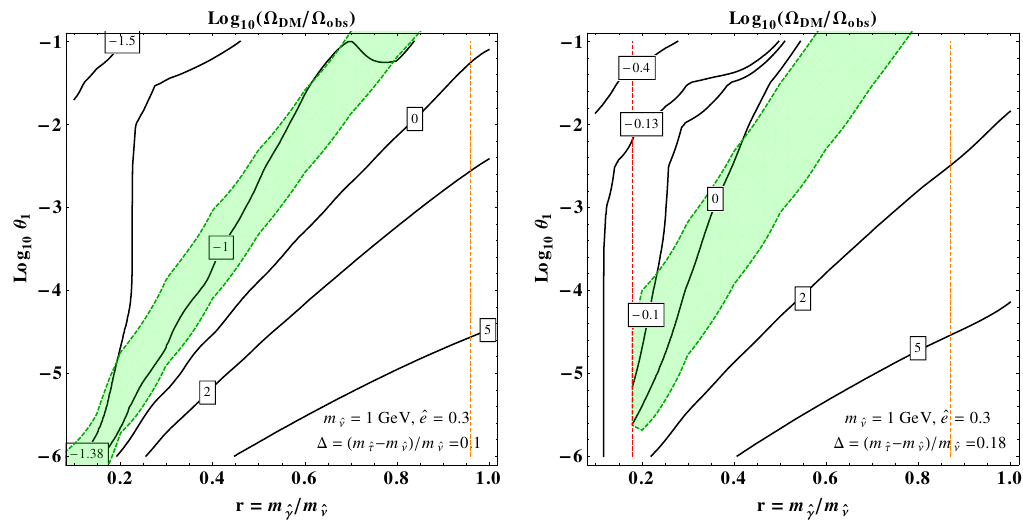
Figure 4 . Relic density for m ^ (cid:23) = 1 GeV and (cid:1) = 0 : 1 and 0.18. Contours of (cid:12)xed log values are depicted. The shaded green region indicates the mixed phase where T S (cid:24) T C region to the lower right of the green band is in the coscattering phase while the coannihilation phase is in the upper left corner. In the region to the right of the orange dashed line, C A becomes important and it enters the C A = S mixed phase. The contours become slightly less sensitive to m ^ (cid:13) or r . The red dashed line indicates r = (cid:1). To its left the ^ (cid:28) $ ^ (cid:13) + ^ (cid:23) decay and inverse decay are open. Their large rates keep ^ (cid:28); ^ (cid:23) in chemical equilibrium, making this region coannihilation-like.